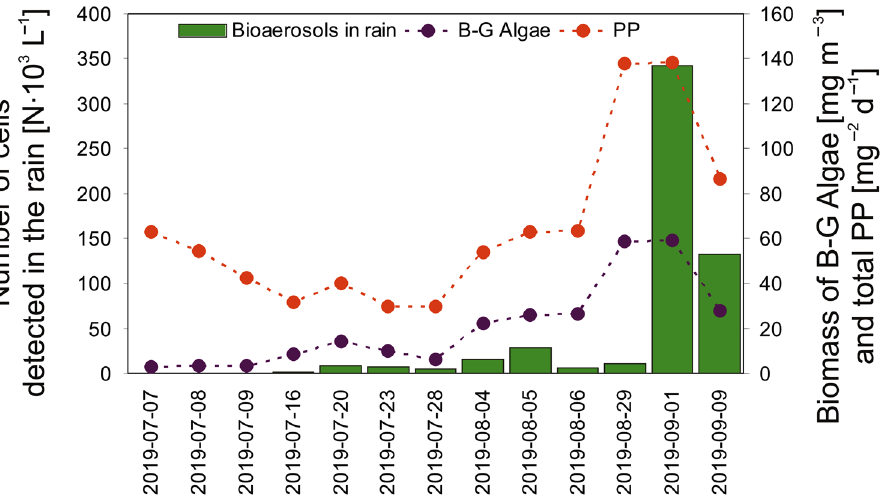
Figure 1. Number of cyanobacteria and microalgae cells present in the rainfall samples and the corresponding changes in their primary production (PP) and the biomass of cyanobacteria (B–G Algae) in the Gulf of Gdańsk (http:// model. ocean. univ. gda.